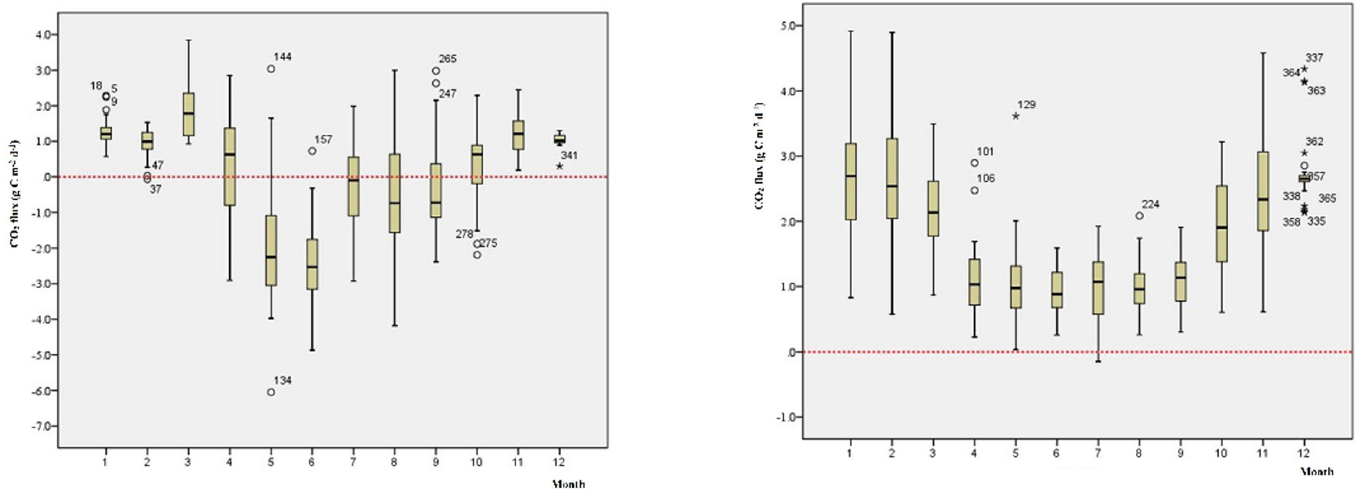
Fig 4. Monthly variations of the CO 2 flux at 5R (a) and DB